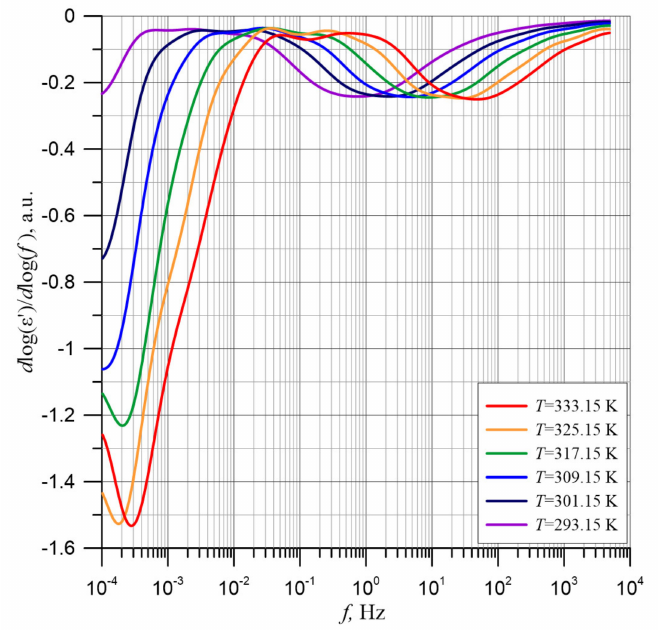
Figure 5. Frequency dependence of d (log ε (cid:48) )/ d (log f ) derivatives for temperatures from 293.15 to 333.15